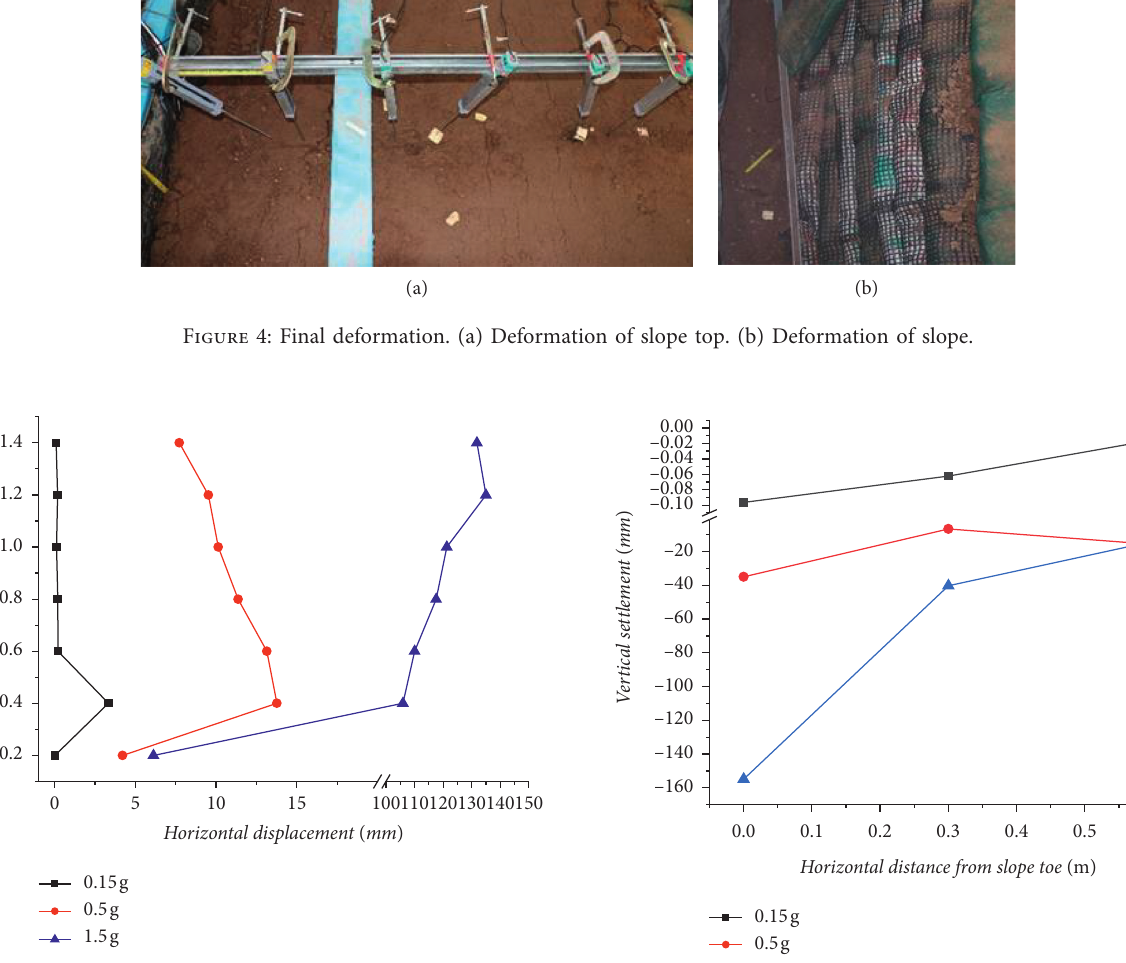
Figure 5: Horizontal displacement of the slope with height.